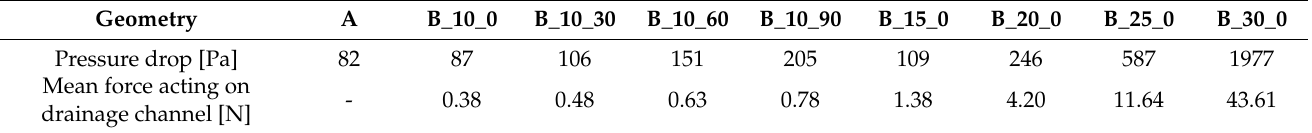
Table 11. Pressure drops on mist eliminators and the mean force acting on drainage channel; inlet velocity 2 m s − 1 . Geometry